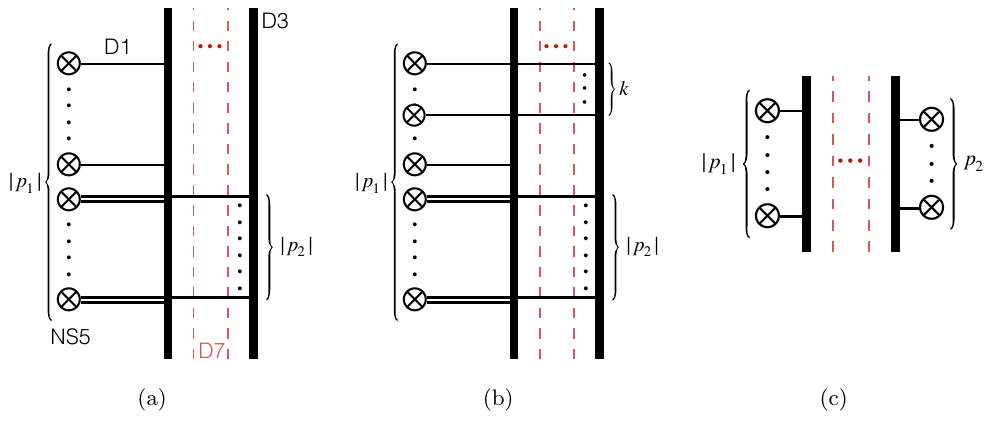
Figure 18 . (a) A brane con(cid:12)guration that realizes the ’t Hooft operator with B = ( p 1 ; p 2 ) such that p 1 (cid:20) p 2 (cid:20) 0. (b) A brane con(cid:12)guration corresponding to the screening of B = ( p 1 ; p 2 ) to v = ( p 1 + k; p 2 (cid:0) k ). (c) A brane con(cid:12)guration that realizes the ’t Hooft operator with B = ( p 1 ; p 2 ) such that p 1 (cid:20) 0 (cid:20) p 2 .